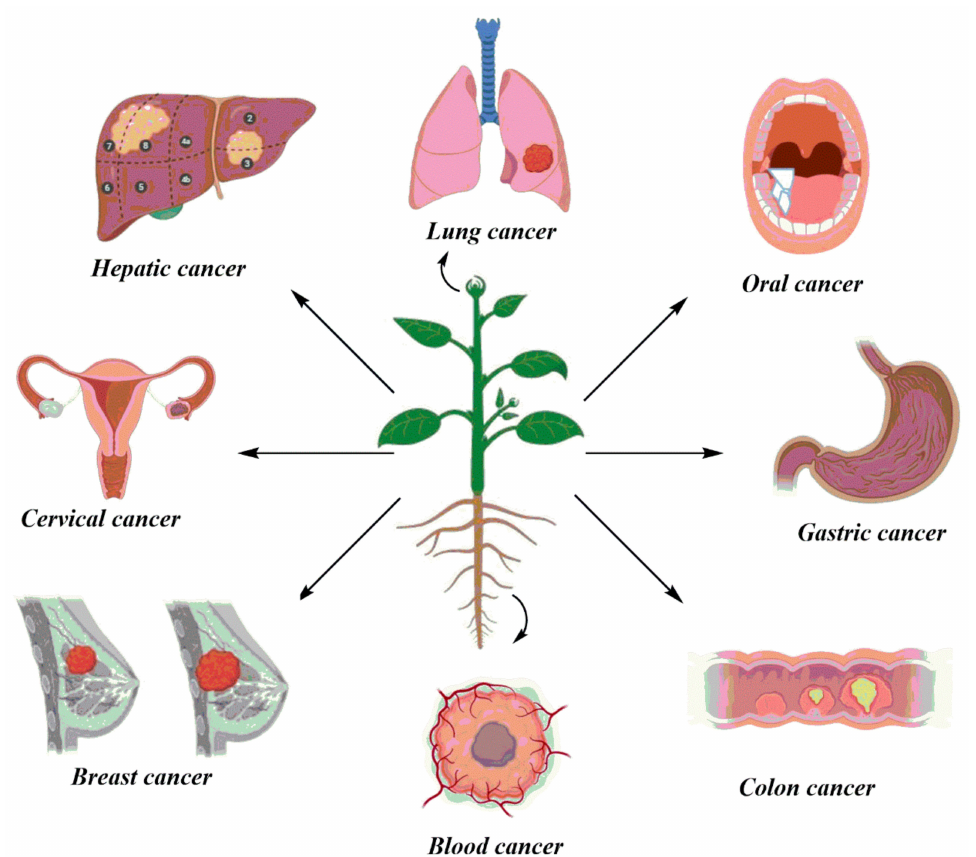
Figure 2. Illustration of activity of plants against several types of cancers. The icons were taken from Biorender illustrator and constructed through ChemBiodraw